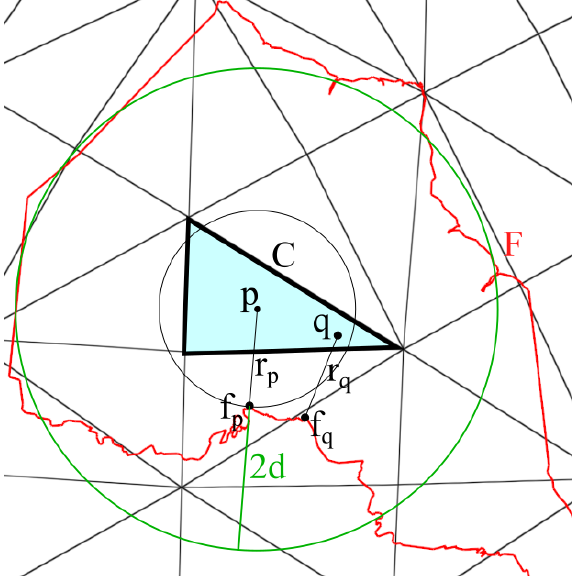
Figure 9. An example of a the bounding space (green